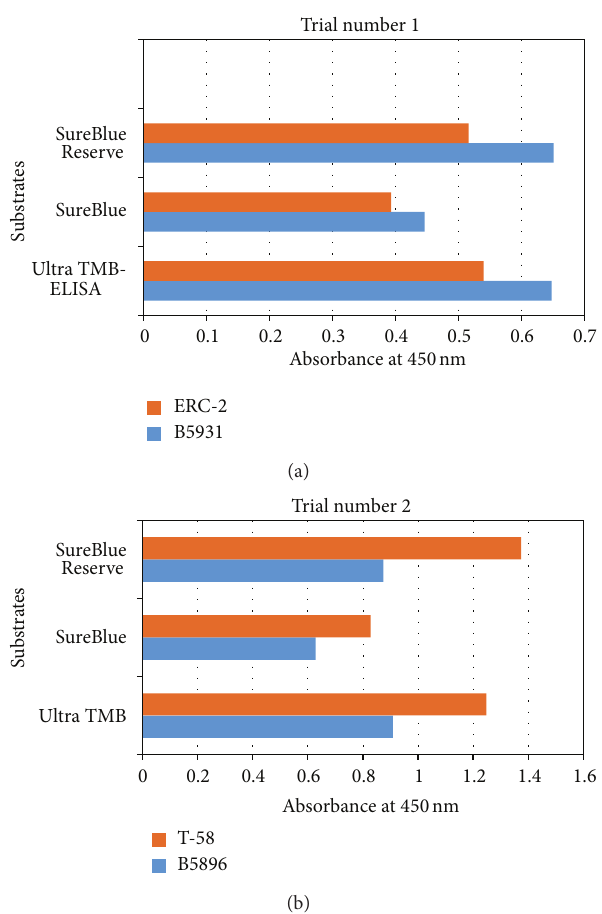
Figure 1: Comparison of the mean absorbance values of lysate anti- gens prepared from dog (ERC-2, T-58) and human (B5931, B5896) isolates using three different substrates (Ultra TMB, SureBlue, and SureBlue Reserve) for antibody detection in the 48 serum specimens from dogs with blastomycosis (24 for each trial: Trial 1 and Trial